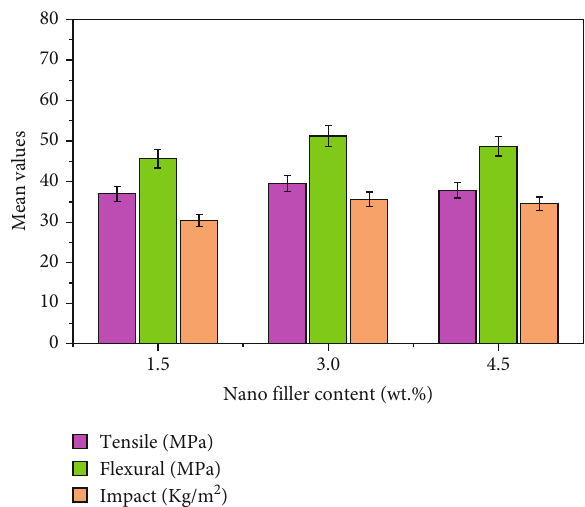
Figure 4: Mean values of tension, bending, and impact strength of hybrid composites based on nano-SiO